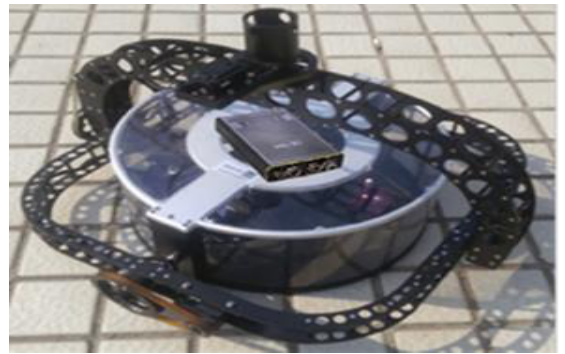
Figure 5. Combined wide angle aerial camera